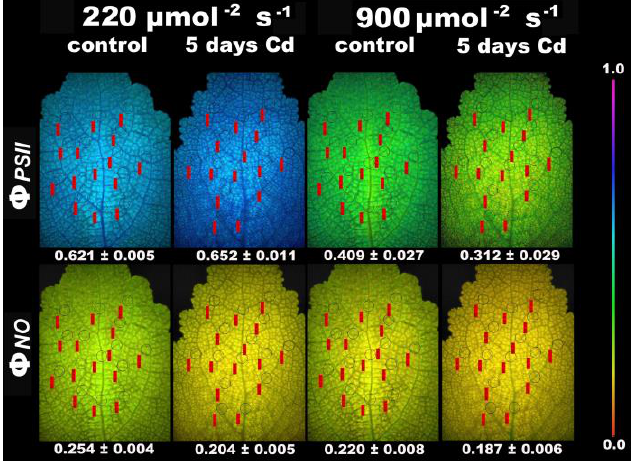
Figure 9. Chlorophyll fluorescence images of Φ PSΙΙ and Φ NO (measured at 220 μmol photons m −2 s –1 and 900 μmol photons m −2 s –1 ) of control and 5 days Cd-treated Salvia sclarea plants. The color code depicted at the right-side ranges from values 0.0 to 1.0. The fifteen circles in each image denote the areas of interest (AOI) that are complemented by red labels with the values of the fluorescence parameter, while whole leaf value is presented.